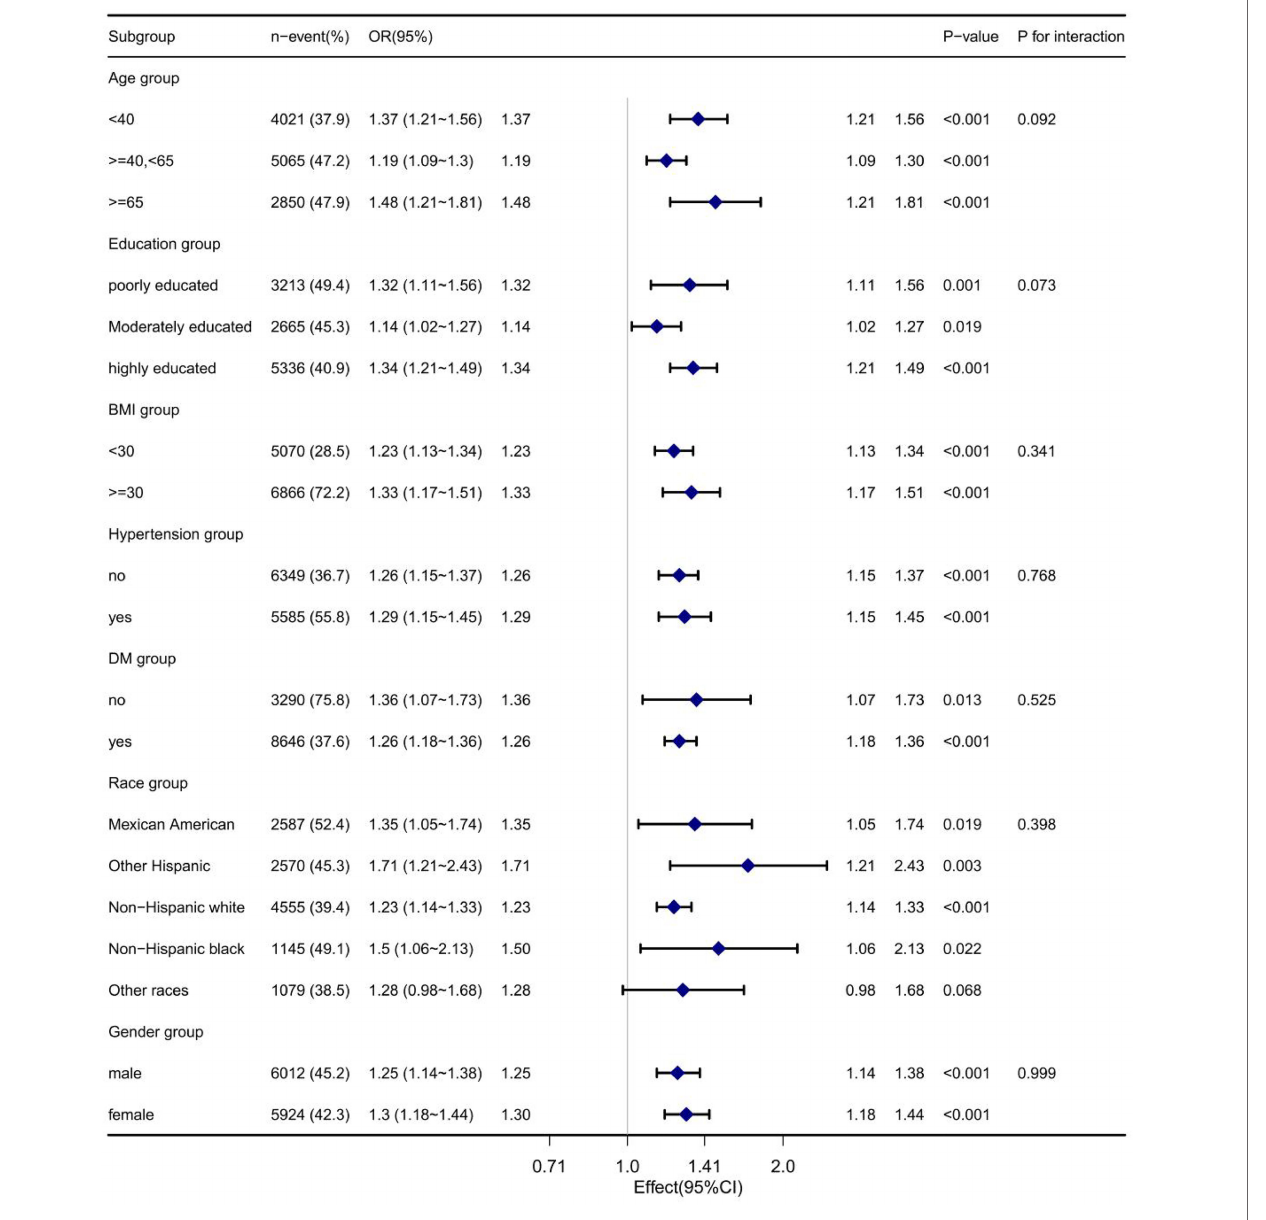
FIGURE 3 | Subgroup analyses of the association between VIA and IR.